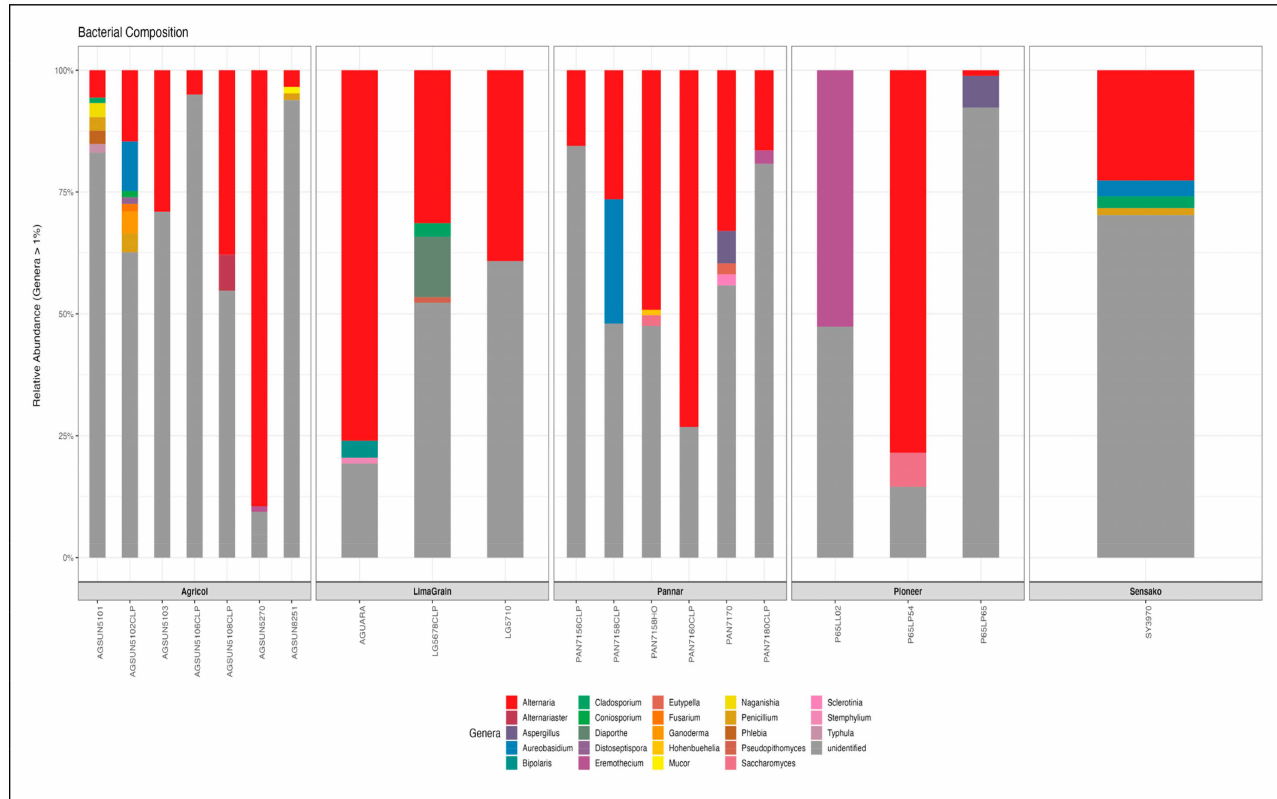
Figure 5. Relative abundance of the dominant fungi Genera from different cultivars of South Africa H. annus seeds. Alternaria was found in almost all the cultivars, though in varying fungi abundance in all the Agricol, Pannar, LimaGrain and Sensako. Cultivars such as AGSUN5102 CLP, LG5678 CLP, SY3970, PAN7158, AGSUN5101 and PAN7170 revealed some level of fungi